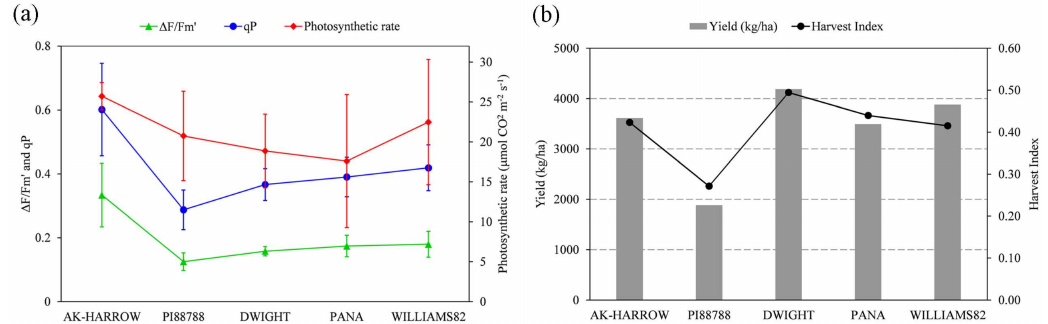
Figure 2. Genotype-average fluorescence yields ( ∆ F/Fm’ ), photochemical quenching (qP) and photosynthetic rates ( µ mol CO 2 m − 2 s − 1 ) measured on 13 August 2014, along with harvest